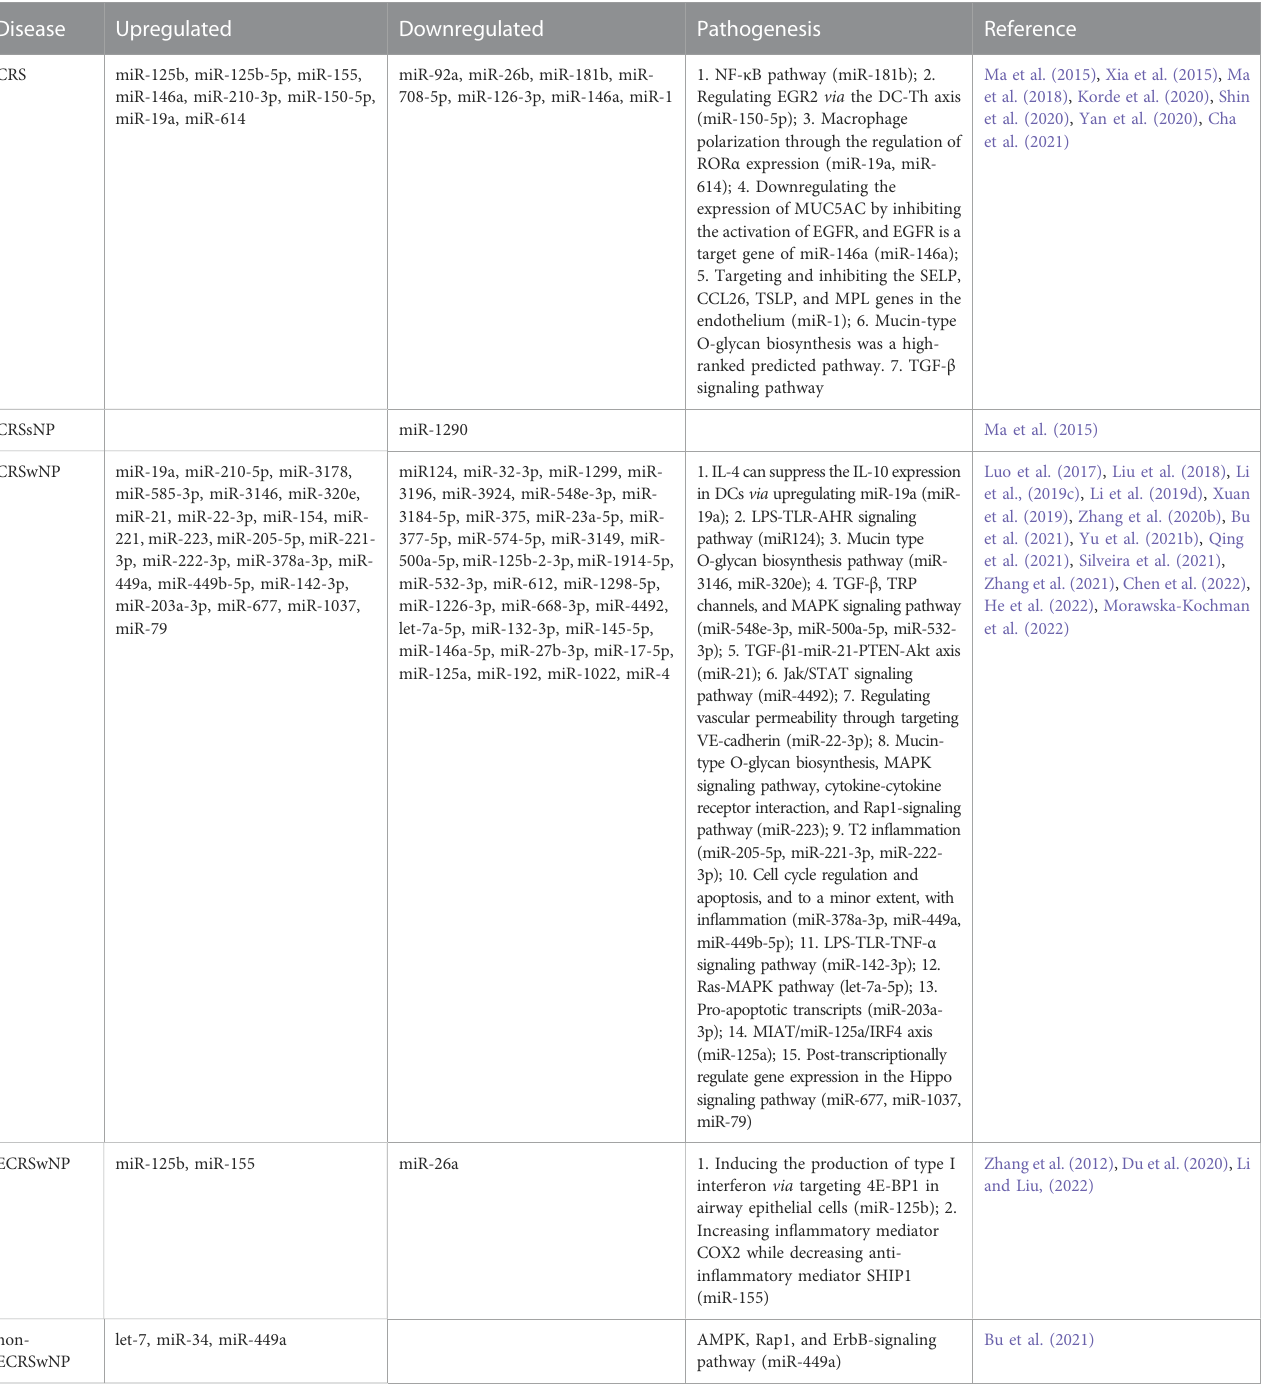
TABLE 2 MicroRNAs involved in chronic rhinosinusitis. Disease